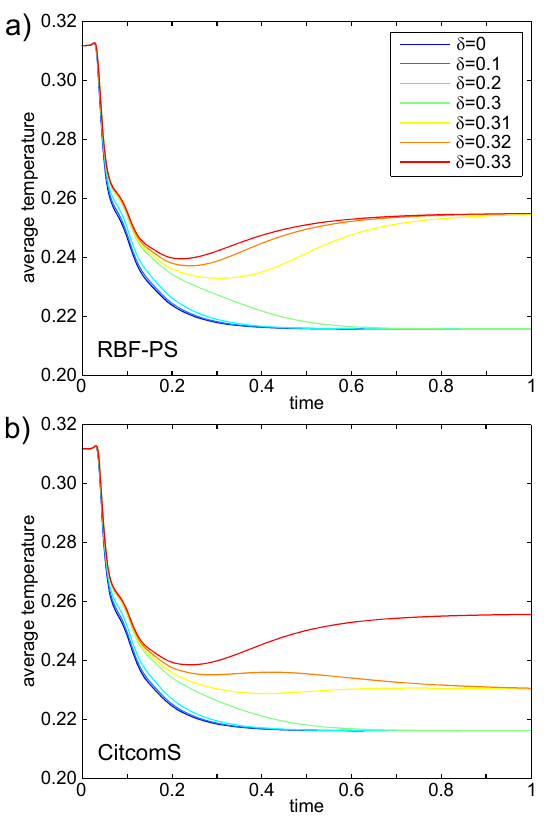
Figure 3. Time trace of the volume-averaged temperature for the cubic initial conditions at Ra = 7000 for 0 ≤ δ ≤ 0 . 33. CitcomS shows transition to three steady states, while RBF-PS shows only two. See Fig. 2 for the final pattern of convection associated with each